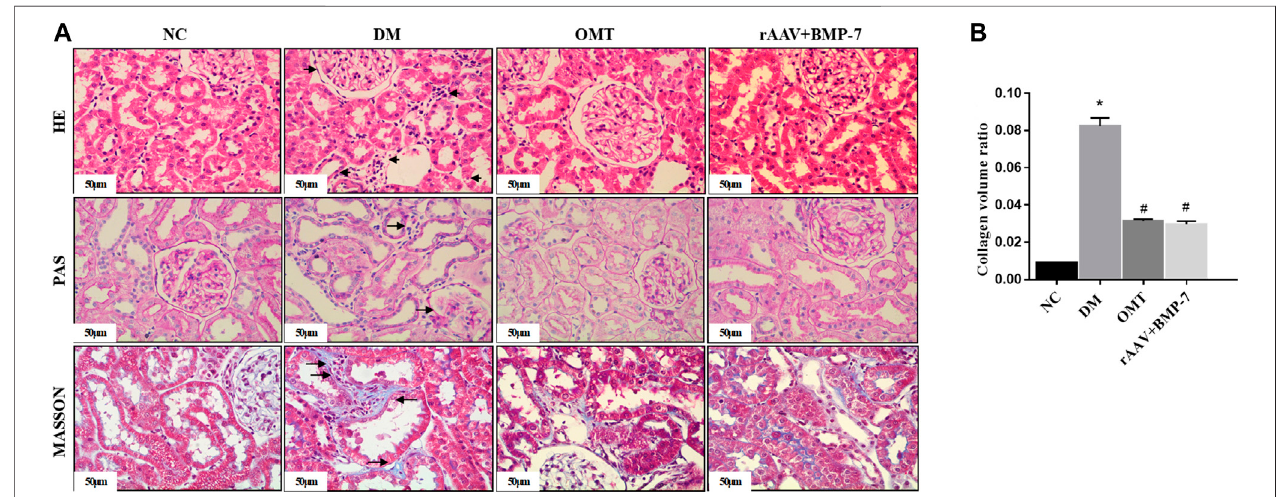
FIGURE2| Paraf fi nsectionsofratkidney tissues ineach groupwerestained withHE,PAS,and MASSON(scalebar is50 μ m),and theratioofcollagenareatothe total area of the tissue under each fi eld was counted, * p < 0.05 vs. NC group, # p < 0.05 vs. DM group.